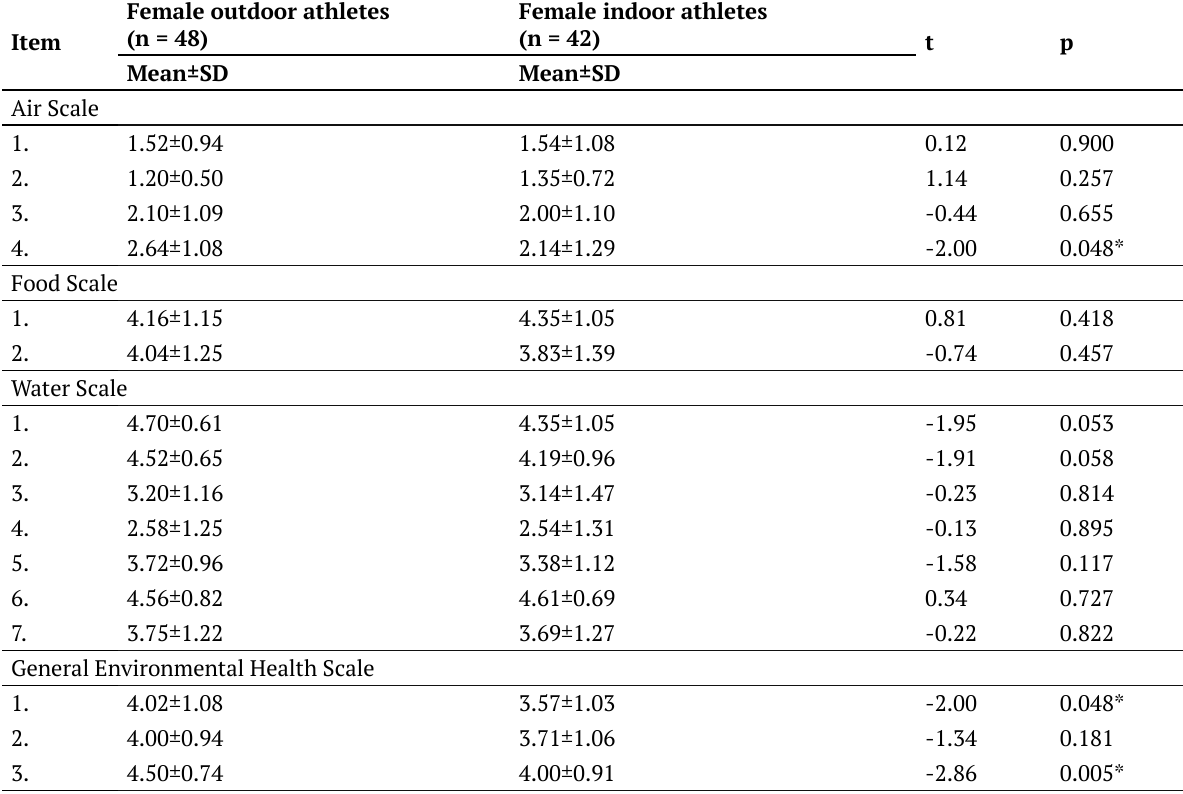
Table 4. Behaviour declared by female outdoor athletes and female indoor athletes within Environmental Health